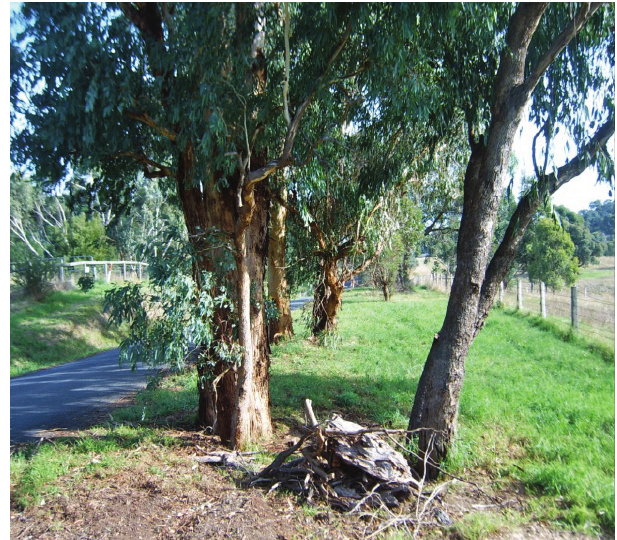
Figure 1. Yellow Box trees at Warrandyte, Victoria, 2012. (Image source: